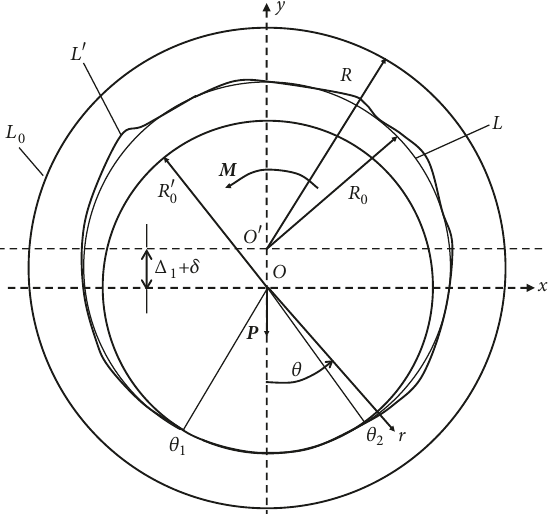
Figure 1: Design diagram of contact problem for hub-plunger friction